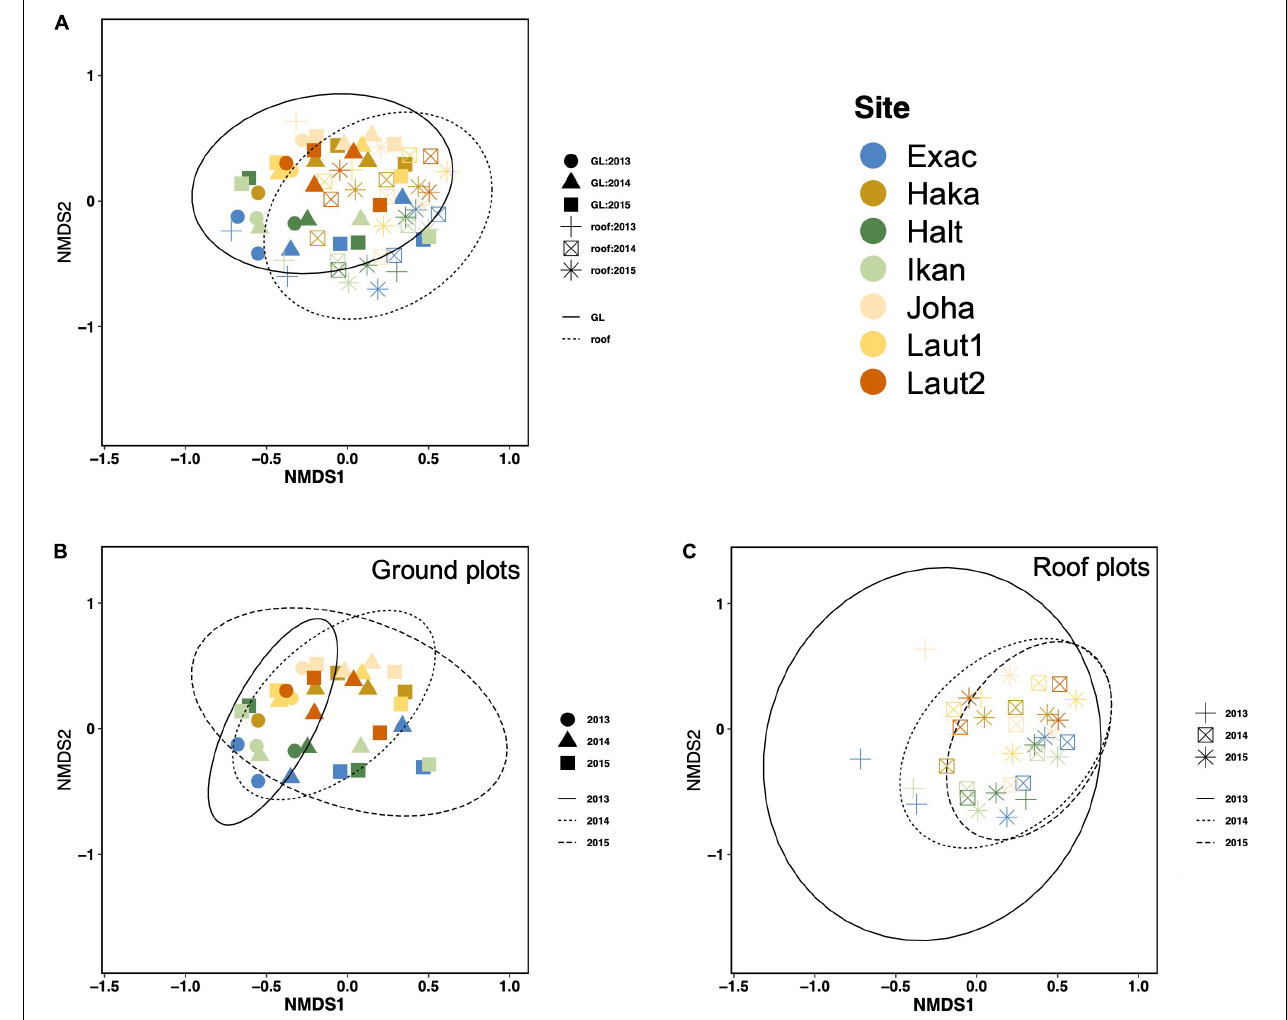
FIGURE 6 | Non-metric multidimensional scaling (NMDS) of arthropod communities at ground level and on vegetated roofs (A) . Plot (B) shows the results for ground sites only and plot (C) for roofs only. The 95% CI ellipses are drawn for plot type (A) or year (B,C) . Different colors present different sites and the sampling occasions of the same year (early and late summer) are plotted with similar symbols. One observation (Laut2 roof, 2013 1st sampling event) was removed as an outlier from the NMDS